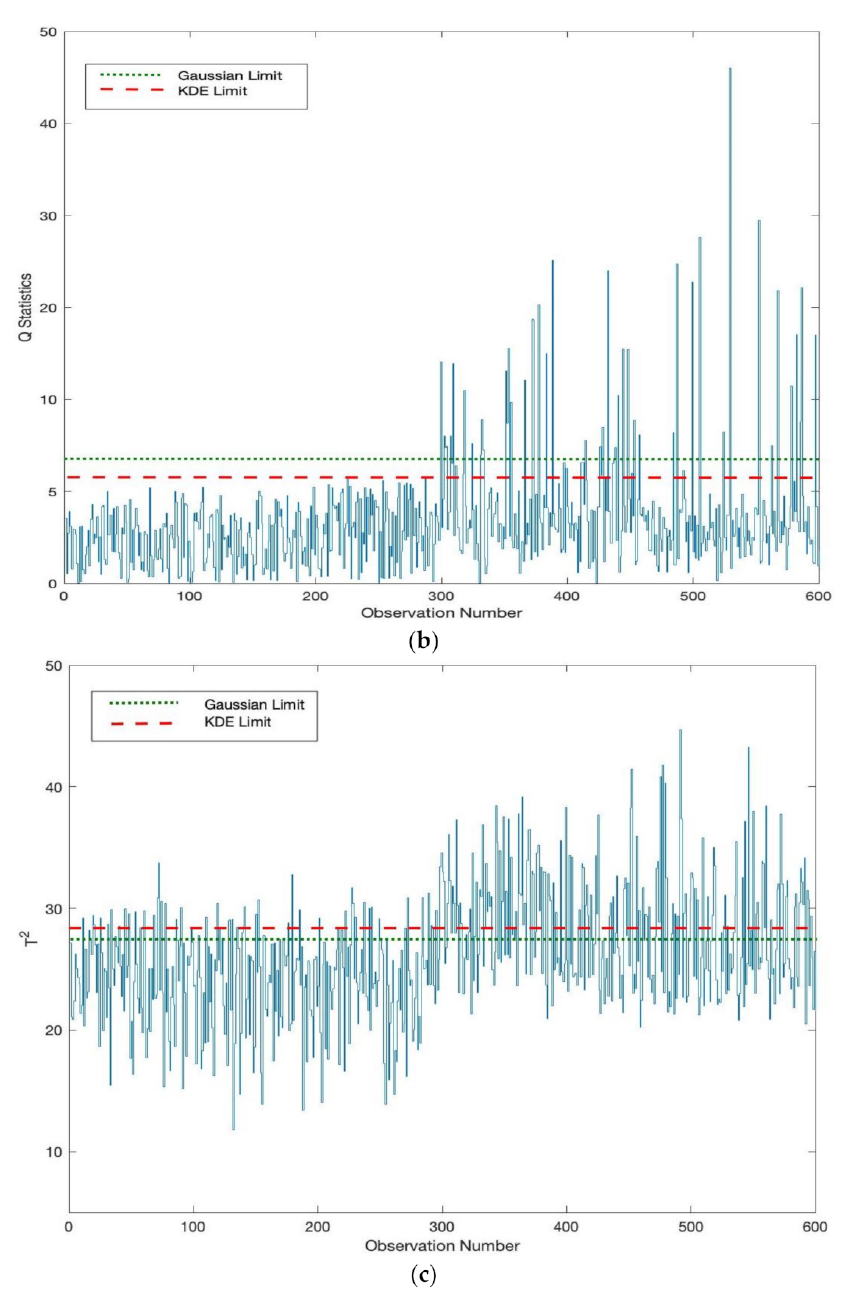
Figure 7. ( a ) Monitoring fault IDV 12 using KPCA-KDE-SSGLR chart; ( b ) monitoring fault IDV 12 using KPCA-KDE based Q chart; ( c ) monitoring fault IDV 12 using KPCA-KDE based T 2